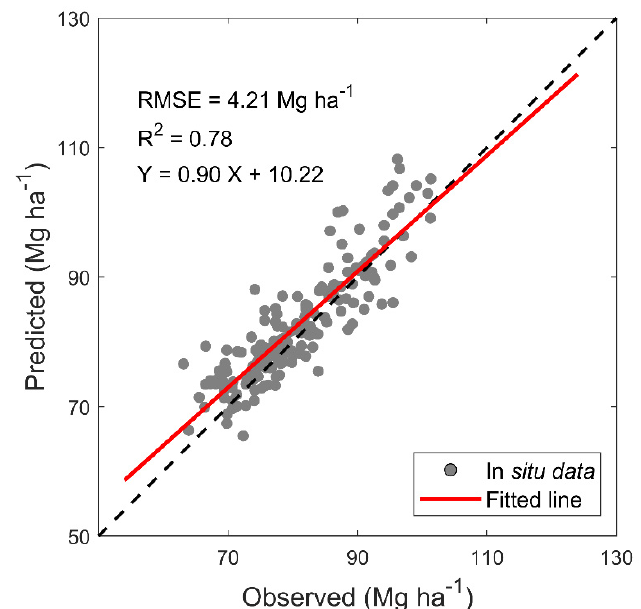
Figure 3. Verification of the model by dividing the validation data independent of the training data when using the training model. The red line represents the fitting curve that verifies the predicted and true values of the data. R 2 and root-mean-square error (RMSE) of the validation results are used to evaluate our model.